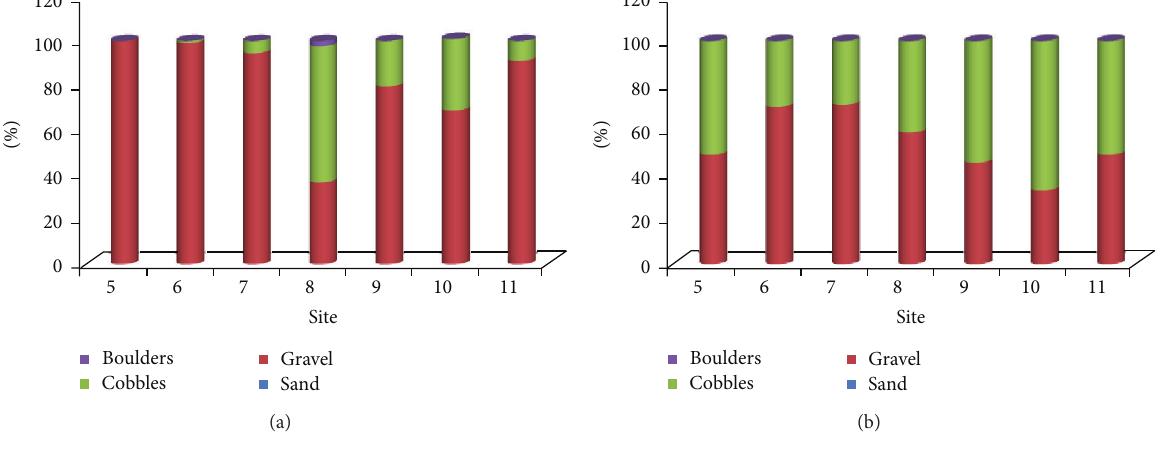
Figure 7: Proportions of clasts from grid method.